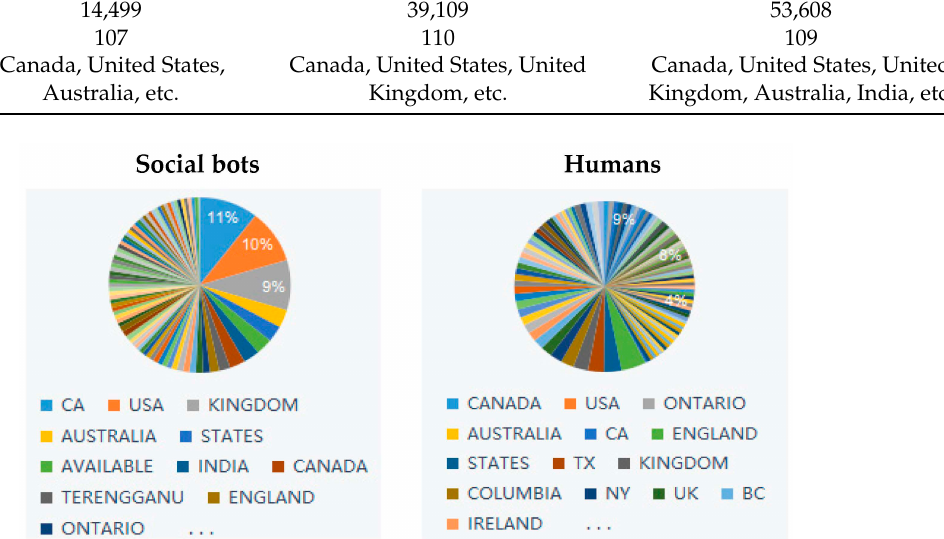
Figure 3. Tweet’s location of social bots and humans.